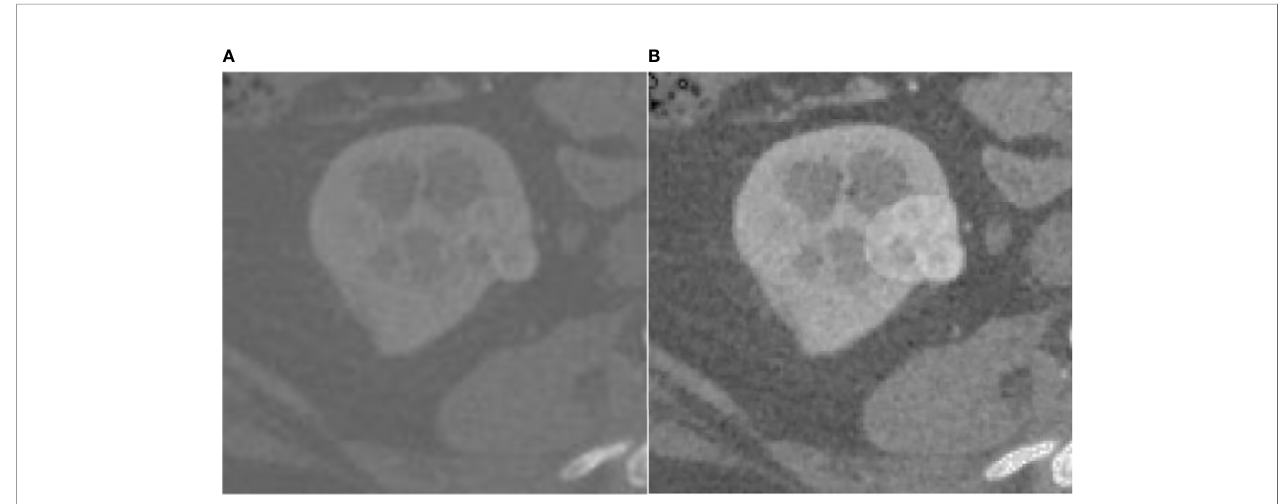
FIGURE 2 | Result of fuzz set enhancement algorithm, (A) is the original CT image, (B) is the image enhanced by the fuzzy